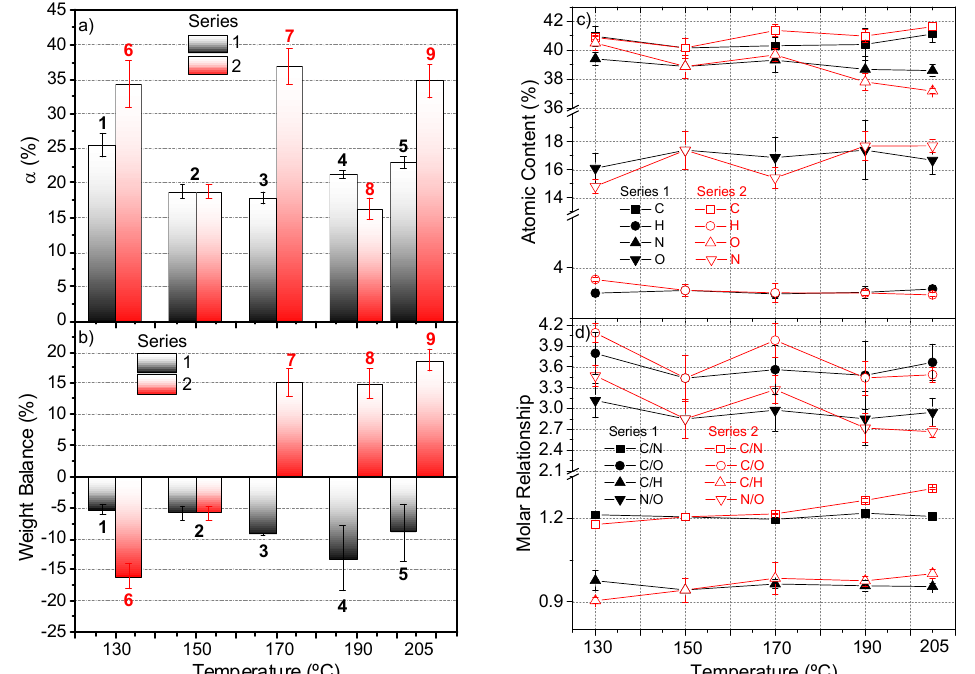
Figure 2. ( a ) Conversion degree, α (%), for the insoluble polymers synthesized according to the reac- tion conditions shown in Table 1. Above each column is indicated the number of the corresponding polymer. Note that the polymer 2 is included in both series. The conversions for polymers 7 and 9 were calculated using the values obtained in seven independent experiments; for the rest of the polymers, at least three independent syntheses were carried out. ( b ) Weight balance for the global NH 4 CN polymerization reactions indicated in Table 1, according with the following expression: Weigh balance (%) = [(mg gel fraction + mg freeze-dried solution) - (mg NaCN + mg NH 4 Cl)]/(mg NaCN + mg NH 4 Cl)]·100. ( c ) Elemental analysis data for the polymers synthetized according to the conditions indicated in Table 1. At least three representative independent samples were measured for each point in the graph; ( d ) corresponding molar ratios. Note that the %O was calculated by the difference. For the C/O and N/O molar ratios, we considered the %O present in the macrostructure after subtracting this percentage from the water absorbed for the polymers as moisture, which was about ~10% for all of the samples. This amount of water was estimated by the TG data discussed below. The elemental analysis data displayed in Figure 2c indicates that the C percentage did not present significant differences among the two series under study, and it was about